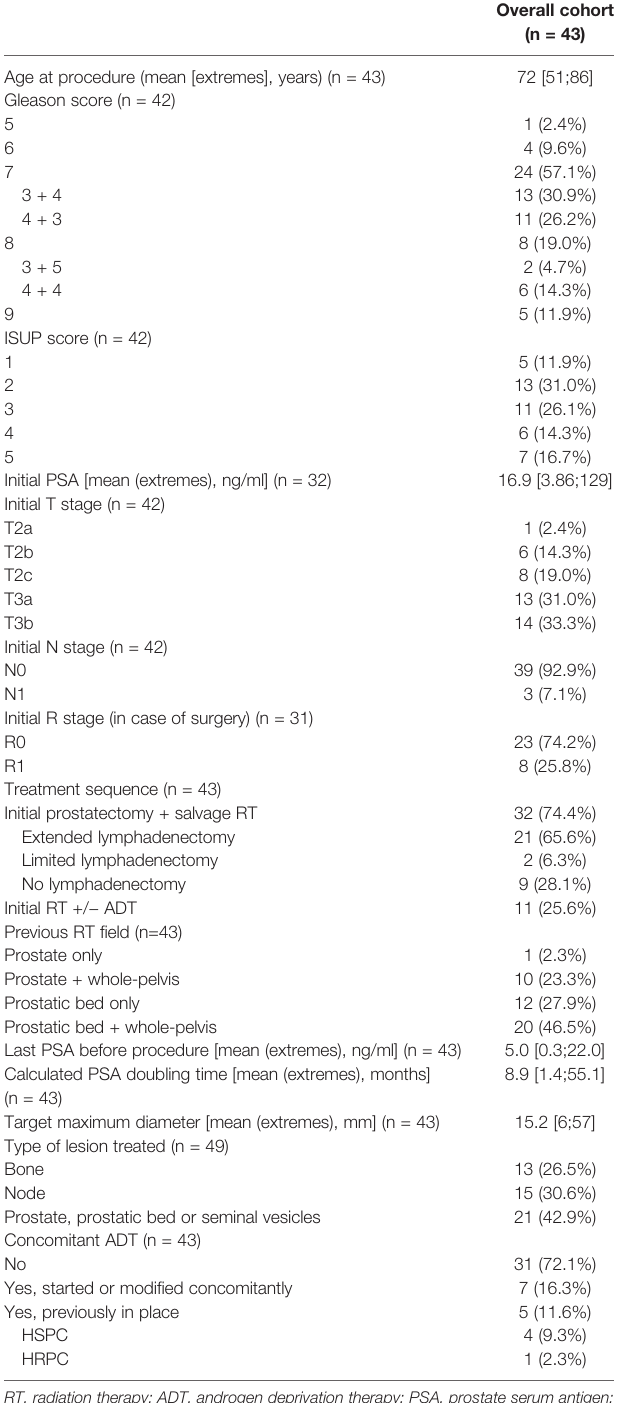
TABLE 1 | Baseline patient characteristics among prostate cancer patients treated by thermo-ablative therapy for in- fi eld oligo-recurrence.